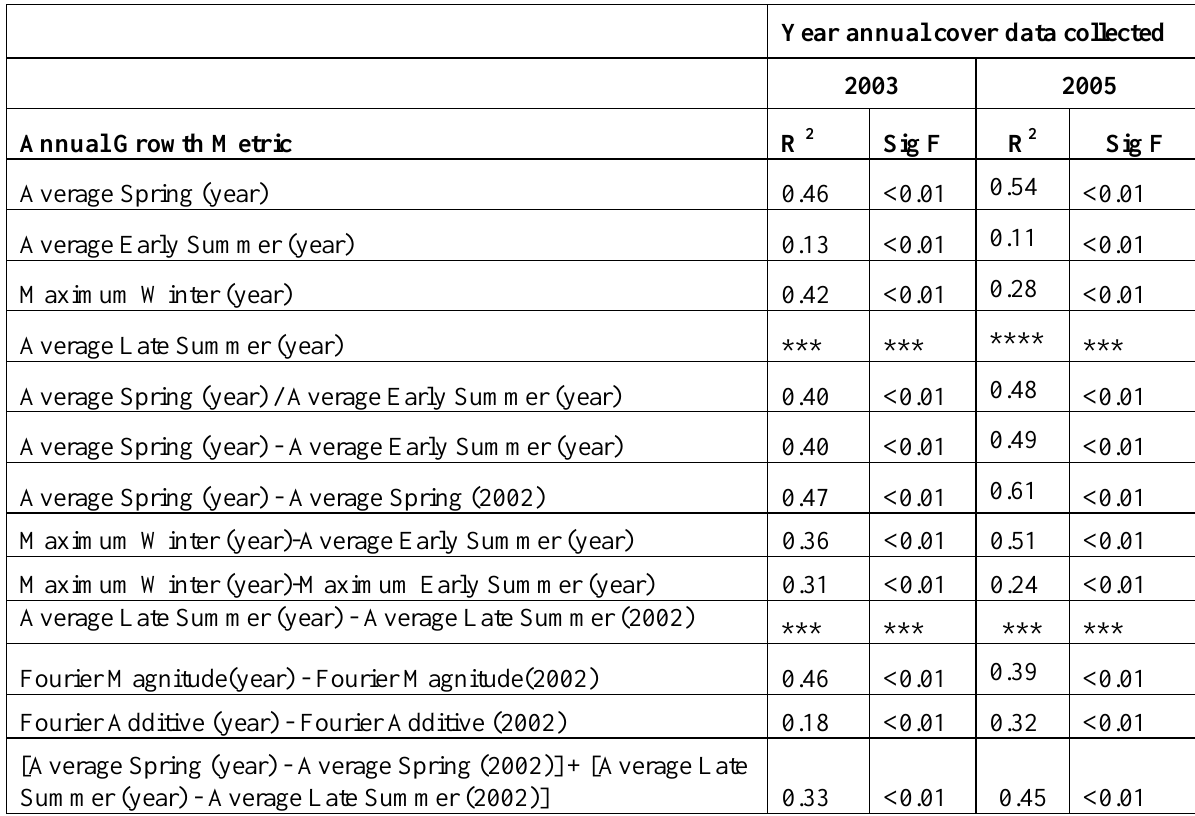
Table 2. Regression results between values predicted by the yearly relative annual growth models and annual cover field estimated in 2003 and in 2005. Forty-nine points were used for the regression using 2003 data, and thirty-six points were used for the 2005 regressions. Insignificant regression results are shown as